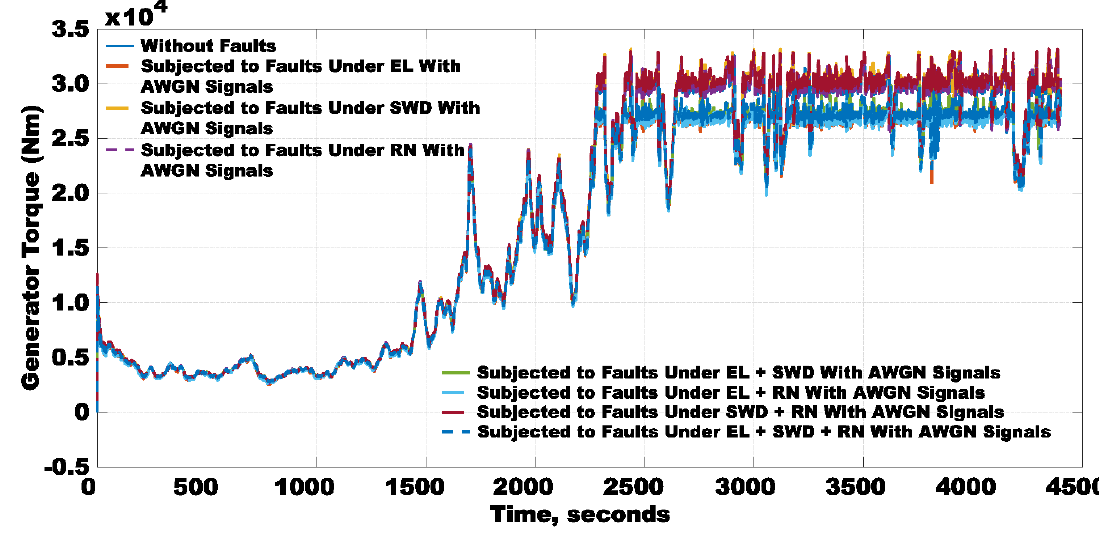
Figure 9. Output responses of four sensor outputs β , ω g , ω r , and τ g , respectively, under healthy and multiple faults operation conditions occurring between 0 and 4400 s: ( a – d ).